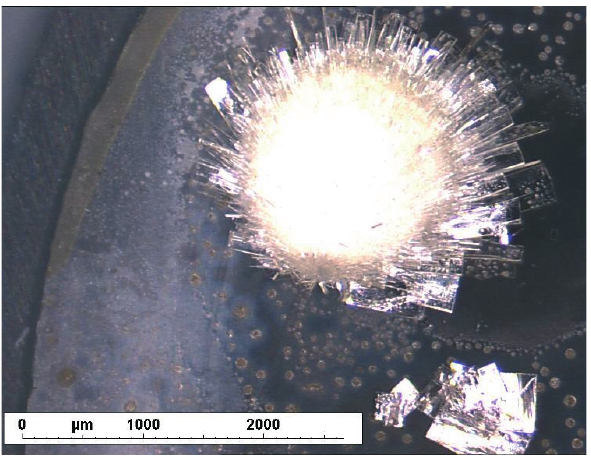
Fig. 2. – Optical microscopy photography of the 2-n-propylquinoline formulation (× 40).